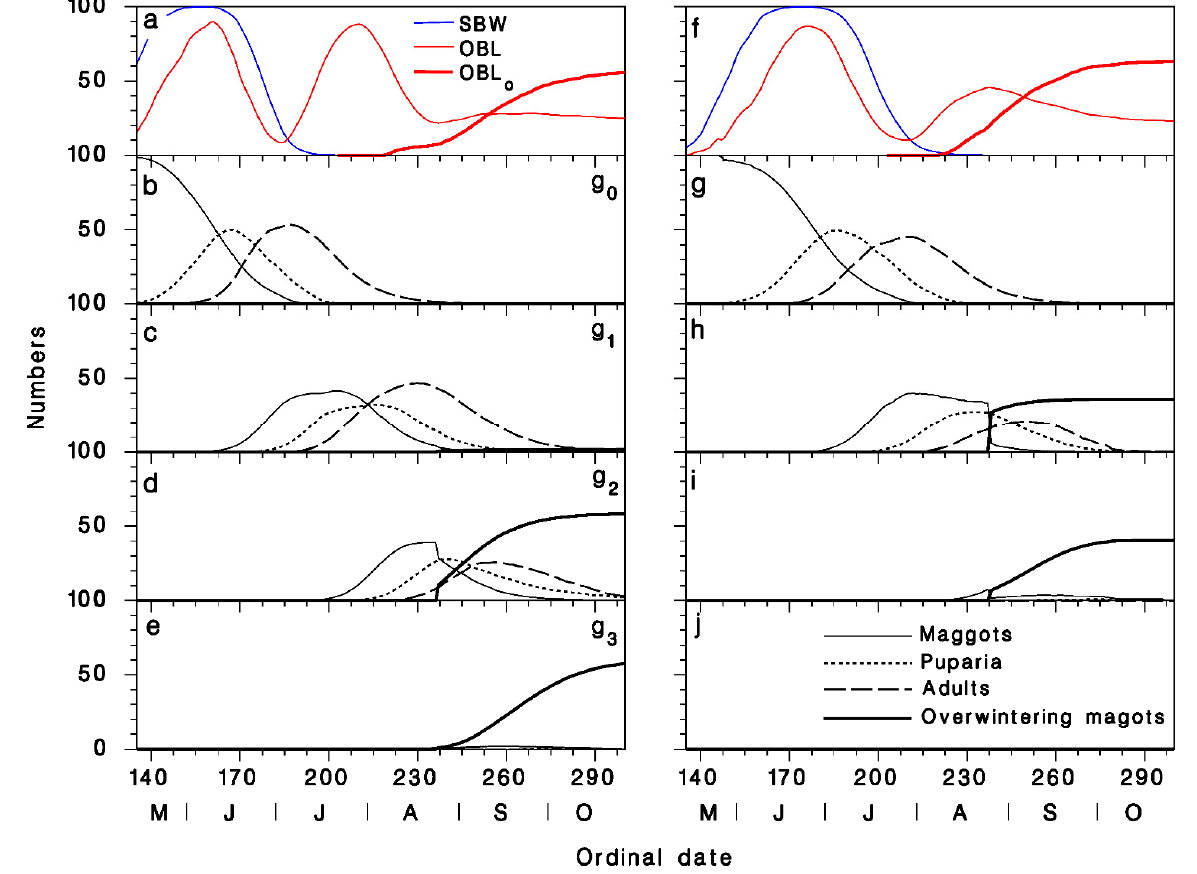
Figure 6. Model output in Armagh ( a – e ) and at Epaule ( f – j ), averaged over the period 1986–2019. ( a , f ) Abundance of larvae of the two hosts C. fumiferana ( blue ) and C. rosaceana (developing: red ; in diapause: bold red ); ( b , g ) overwintered generation of A. interrupta ; ( c , h ) first summer generation; ( d , i ) second summer generation; ( e , j ) third summer generation. Maggots in hosts ( solid ), puparia on foliage ( dotted ), adults ( dashed ) and overwintering maggots (technically, part of the following generation; bold ).